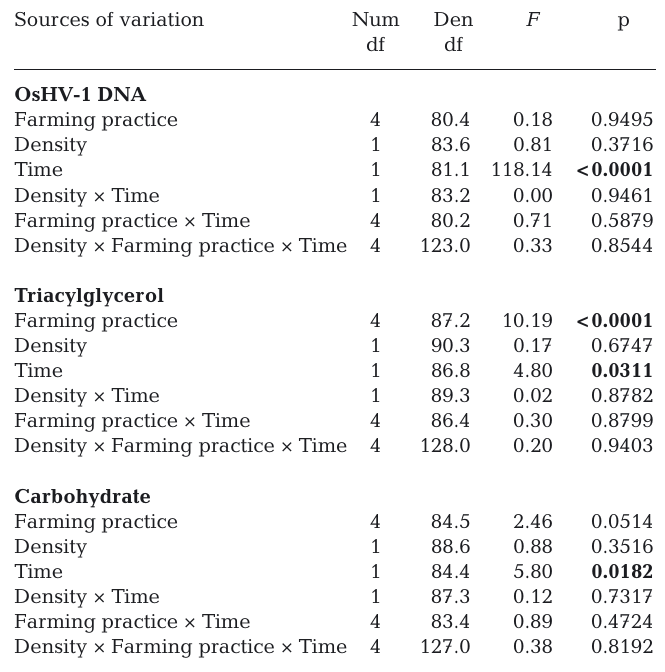
Table 3. Results of the 2-way split plot ANCOVAs examining the ef- fects of farming practices: outside vs. inside bivalve farms (mussel, empty, oyster [half-grown, spat]); and time: 6 and 16 April, on quantity of herpesvirus OsHV-1 DNA detected in oyster tissues and their ener- getic reserves (triacylglycerol and carbohydrate). Occupation rate (density) of farms was used as a covariate. OsHV-1 data were log (x +